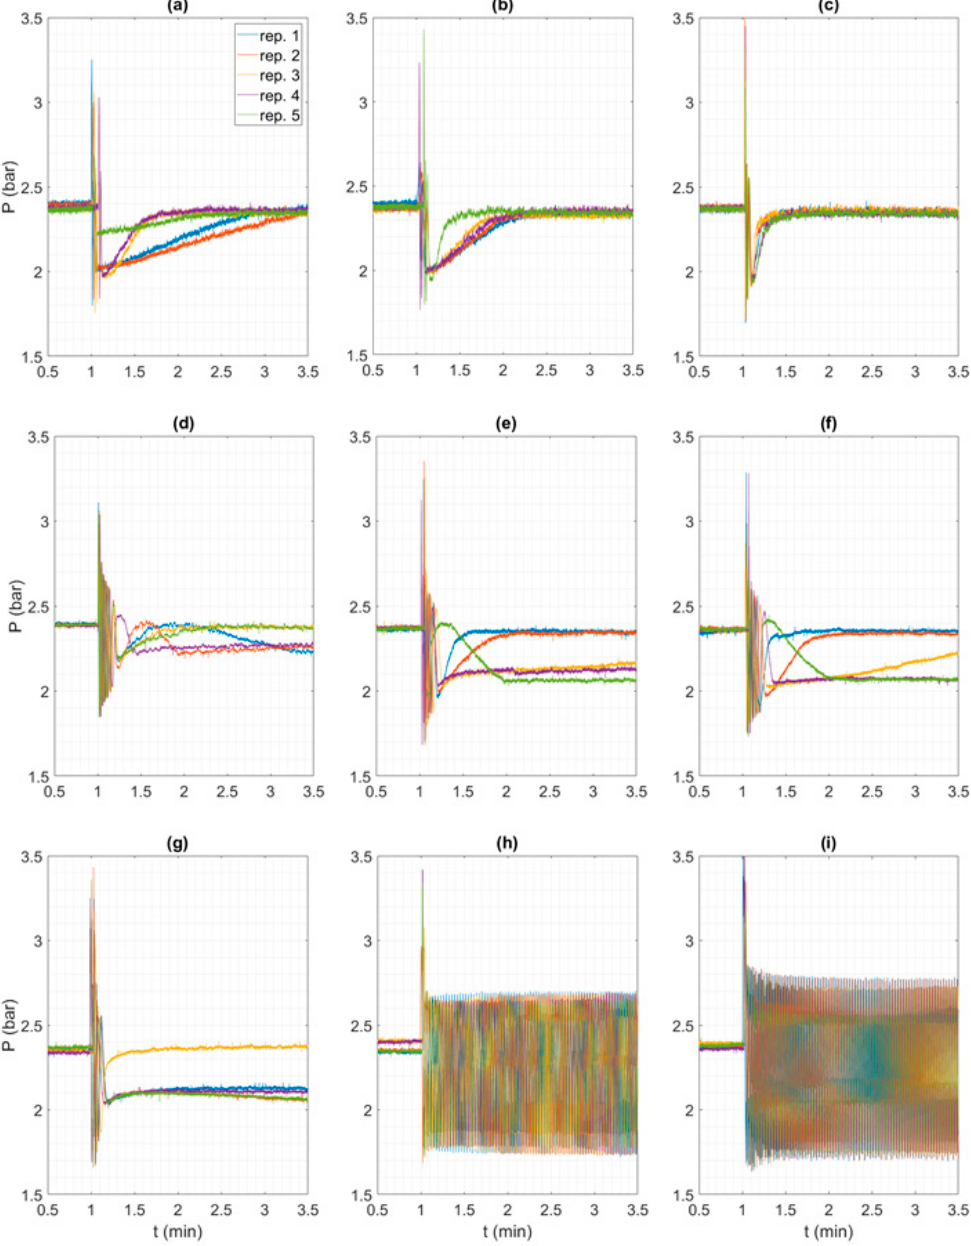
Figure 5. Pressure signals sampled downstream of the PA-PRV (section G) during the nine tests ( a – i ), each repeated five times. Table 2. Stabilisation time intervals (or STs) for tests (a), (b) and (c).